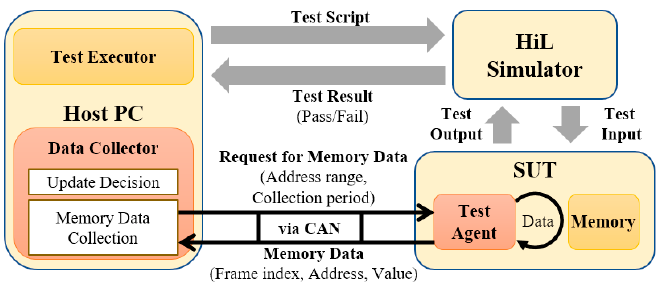
Figure 4. Data collector in HiL testing.